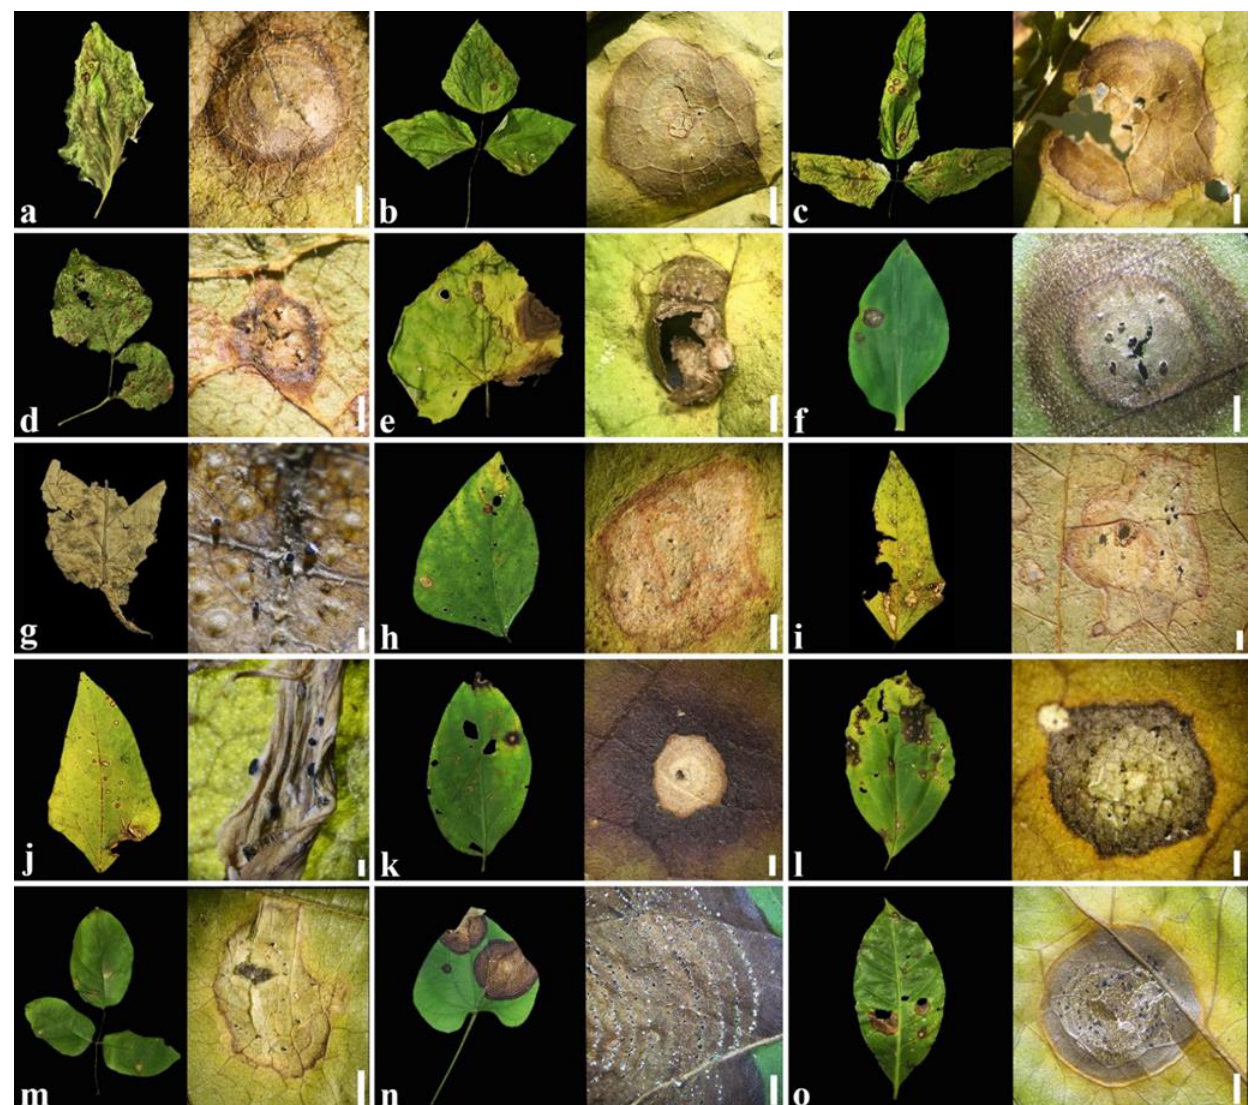
Figure 1. Symptoms on different hosts caused by Paramyrothecium ( left ) and sporodochia on the host surface ( right ); ( a ) Solanum virginianum ; ( b ) Lablab purpureus ; ( c ) Psophocarpus sp.; ( d , i ) Vigna sp.; ( e ) Coccinia grandis ; ( f ) Commelina benghalensis ; ( g ) Tectona grandis ; ( h ) Vigna mungo ; ( j ) Vigna unguiculata ; ( k ) Oroxylum indicum ; ( l ) Spilanthes sp.; ( m ) Centrosema sp.; ( n ) Aristolochia sp.; ( o ) Coffea arabica . Scale bars: ( c , g ,j) = 1 mm; ( b , d – f , l ) = 2 mm; ( a , i , k ) = 4 mm; ( h , m ) = 5 mm; ( o ) = 6 mm; ( n ) = 1 cm.